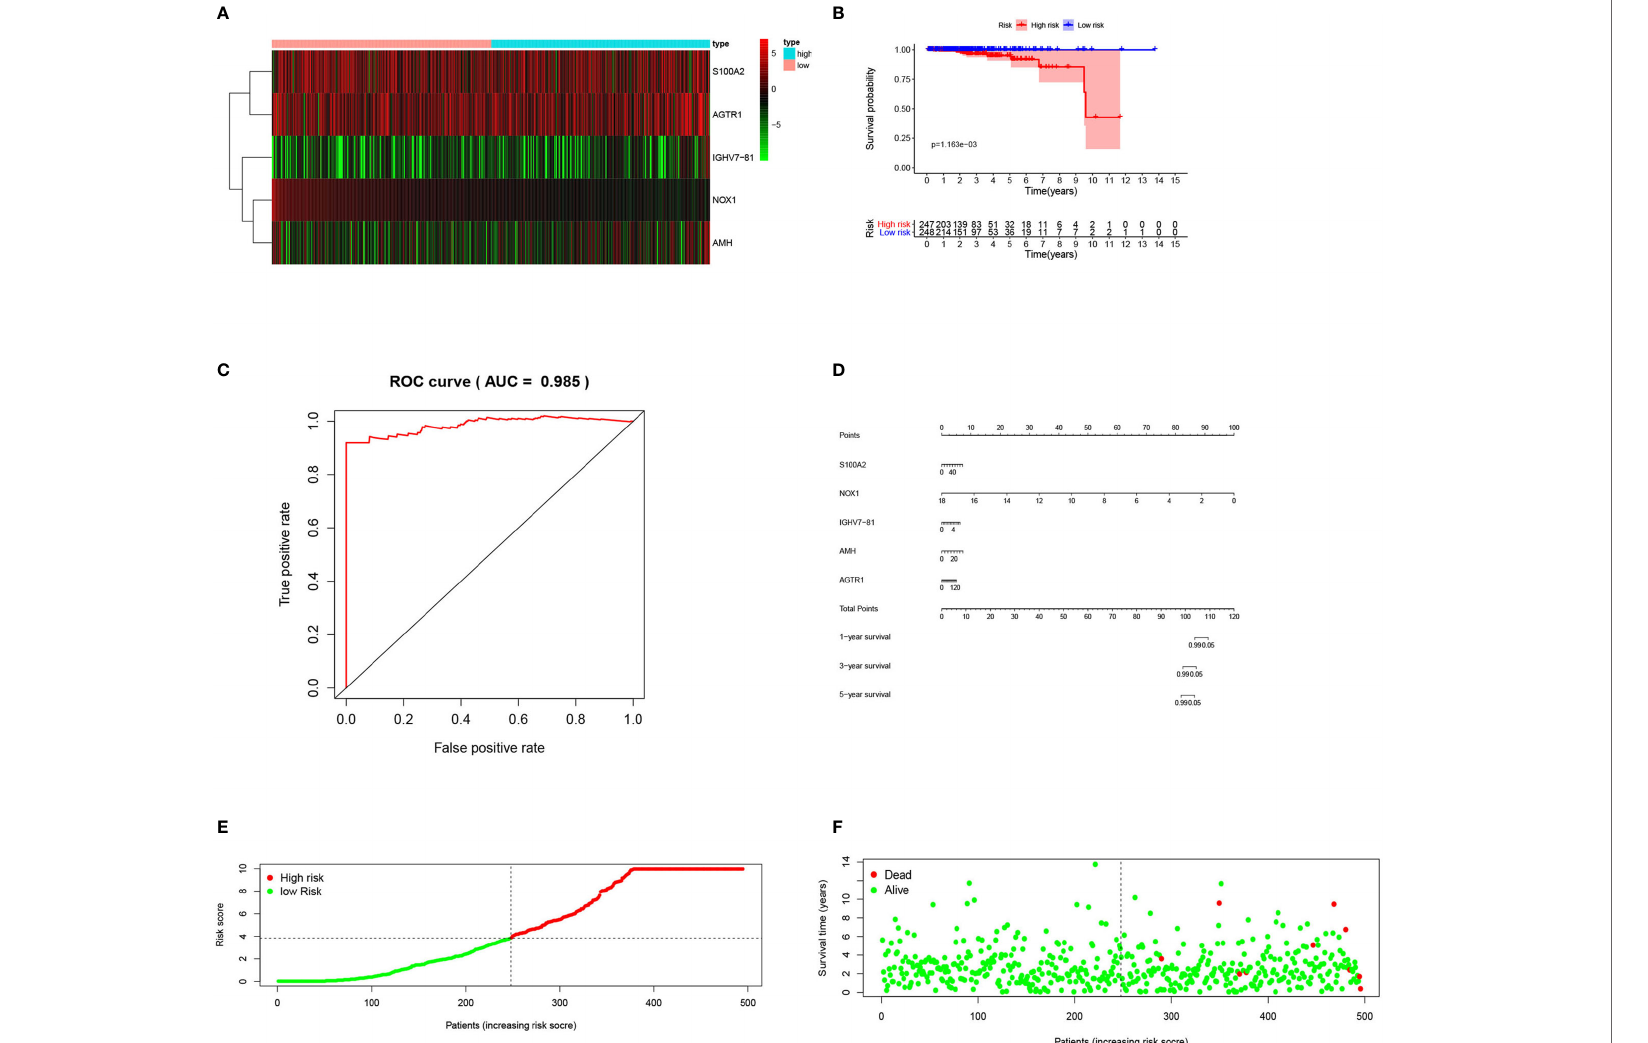
FIGURE 6 | Evaluation of prognostic index based on IRGs for PCa patients: (A) Heatmap; (B) Kaplan – Meier plot; (C) ROC curve; (D) Prognostic nomogram; (E) Risk score; (F)